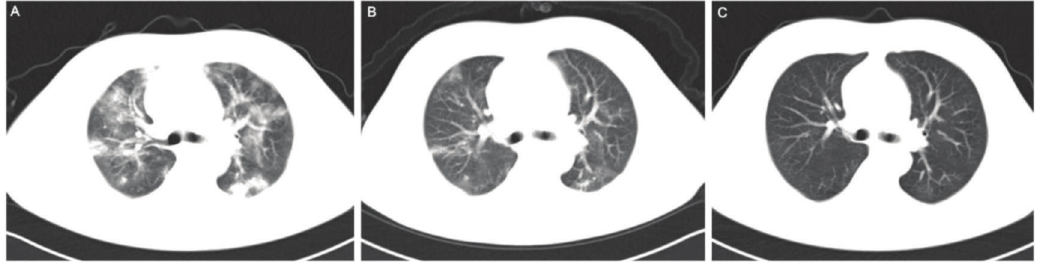
Figure 1 - Chest computerized tomography (CT) images of a patient with COVID-19 treated with MSCs. COVID-19, coronavirus disease; MSCs, mesenchymal stem cells. A. Before MSC therapy; B. 1 week after MSC therapy; C. 2 weeks after MSC